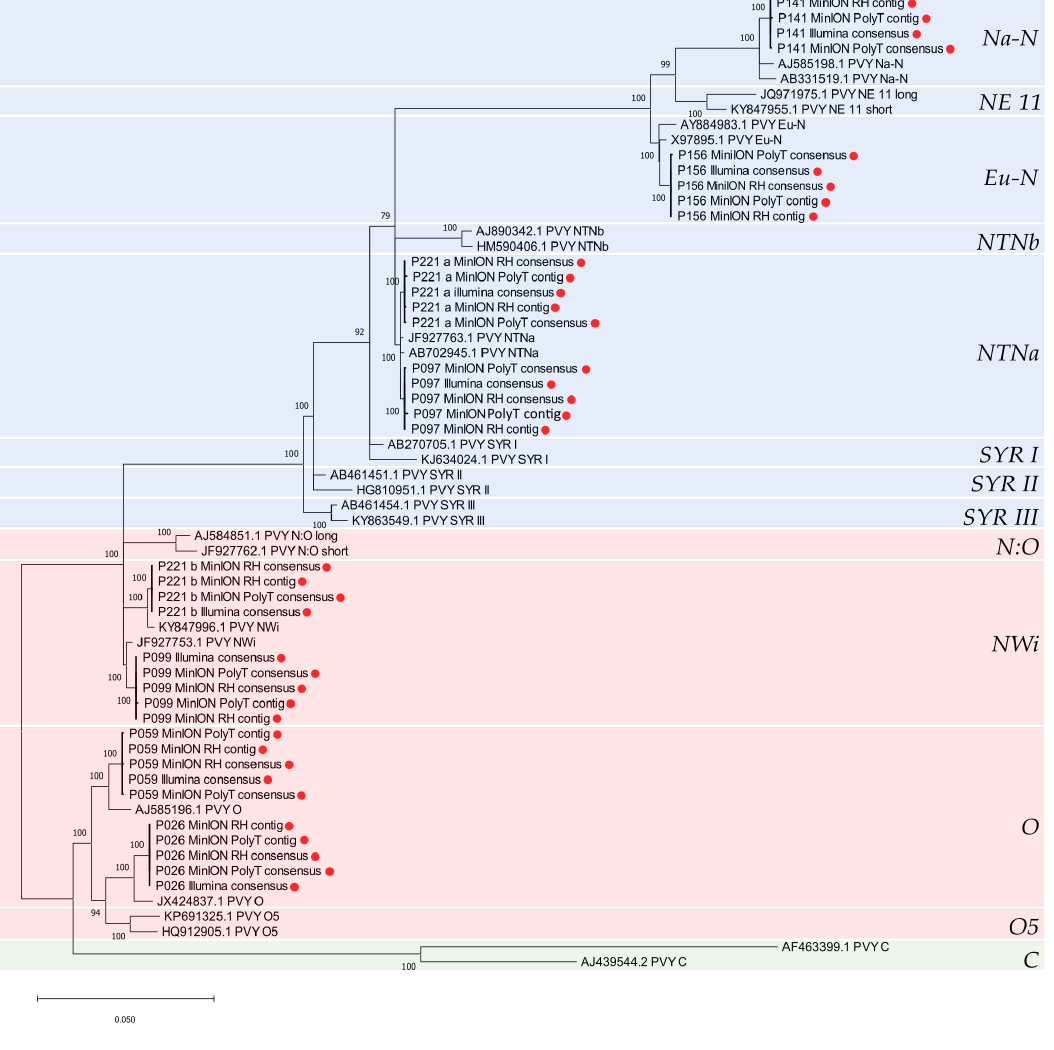
Figure 5. Maximum likelihood phylogenetic tree obtained from the PVY sequences obtained in this study (marked with a red dot) and other 26 PVY genomes retrieved from GenBank. Branch lengths indicate the number of substitutions per site. Only bootstrap values higher than 70% are shown. Serological groups are indicated with di ff erent background colors (green for C serotype, red for O serotype and blue for N serotype). Boxes indicate di ff erent genotypes of the virus; name of the genotype is reported on the right side of the